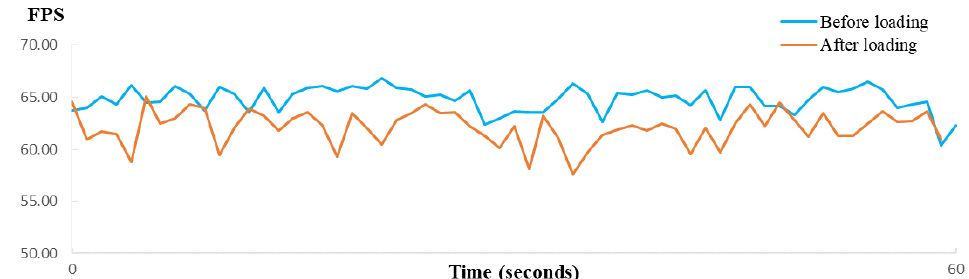
Figure 15. Average frames per second (FPS) before and after loading for experimental area 2.